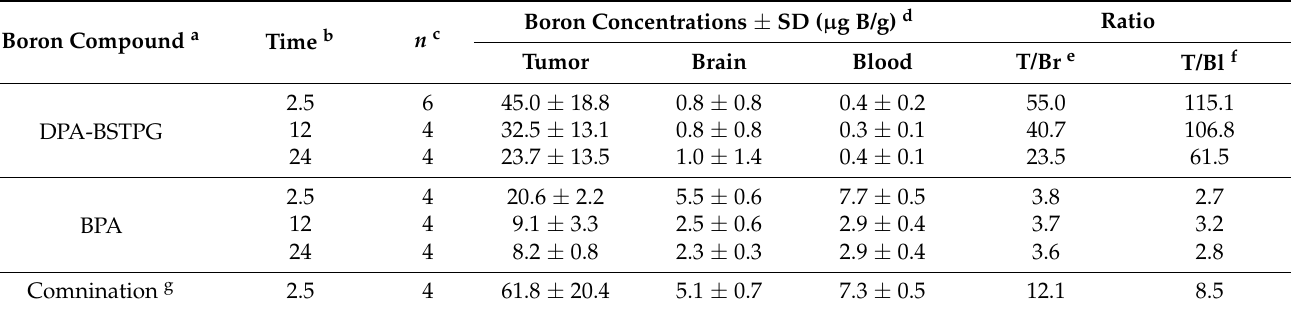
Table 1. Summary of the boron concentrations after administration of each boron compound on the F98 rat glioma